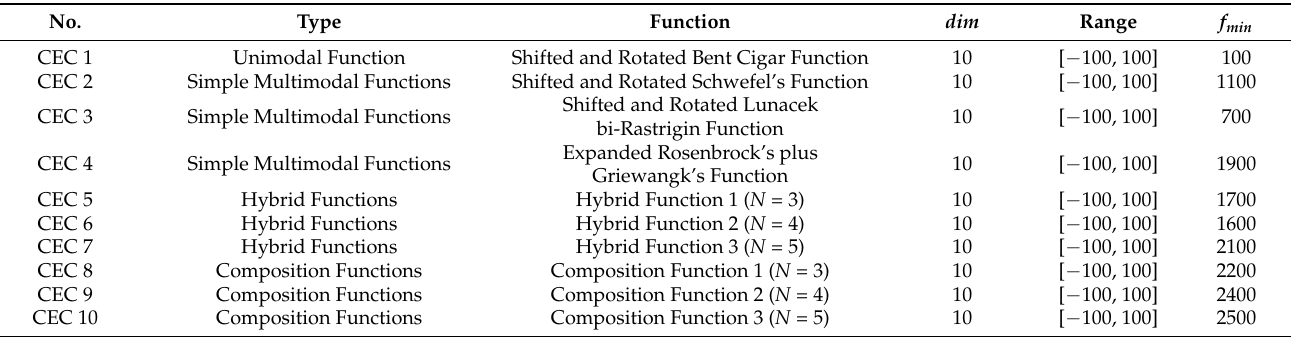
Table 7. Details of CEC2020 test functions.